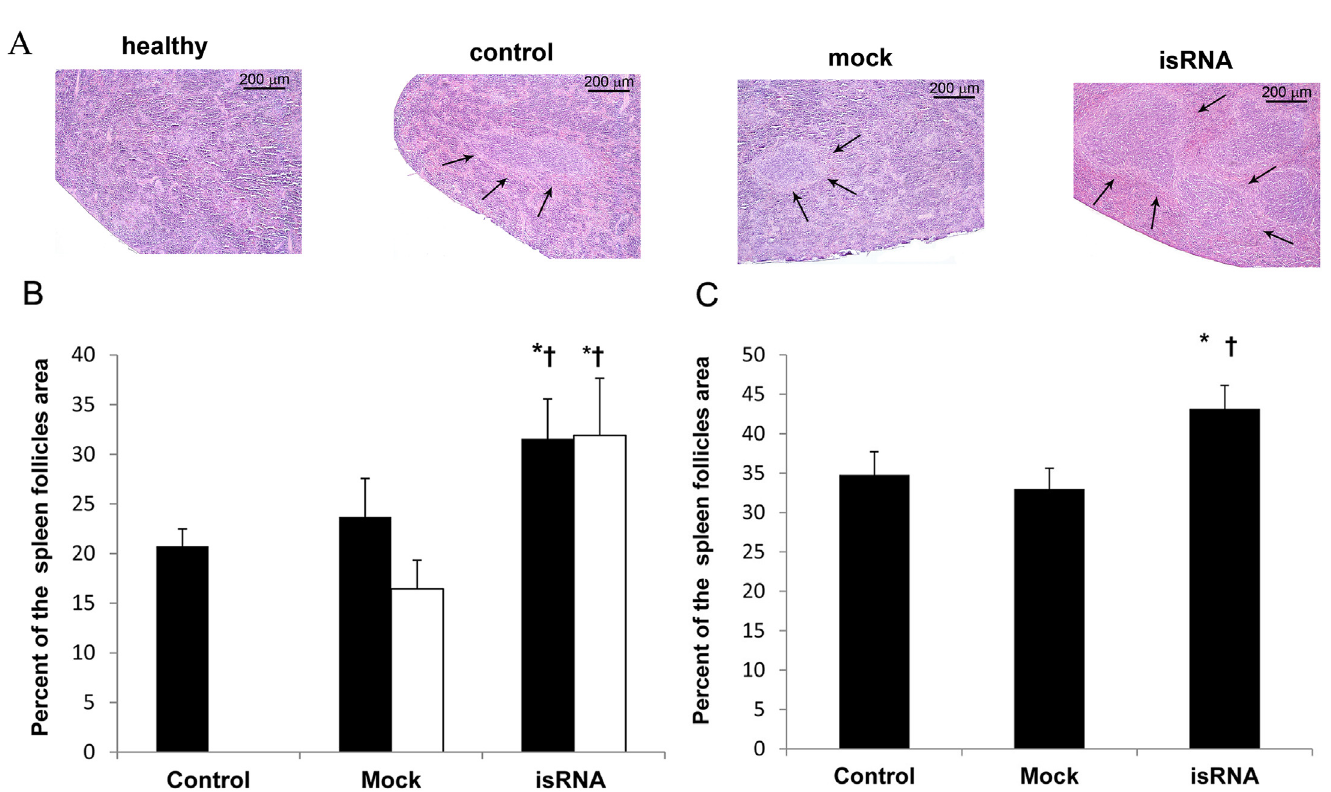
Fig 5. The treatment of melanoma B16-bearing mice with isRNA increases the white pulp area in the spleen. (A) Cross sections of the spleens of the representative mice with subcutaneous melanoma on day 18 after tumor initiation. Arrows show follicles on each image. Paraffin sections, hematoxylin and eosin stain. (B, C) The ratio of the total follicles area to the total area of the spleen for subcutaneous (B) and metastatic (C) melanoma (for details see Materials & Methods). I. v. administration – black bars, p.t. administration – white bars. The data represent mean ± SEM (n = 9). Statistically significant differences between experimental and control groups are indicated by asterisks ( ** , P < 0.01; * , P < 0.05); and differences between experimental and Mock groups are indicated by crosses ( †† , P < 0.01; † , P < 0.05); Mann-Whitney U